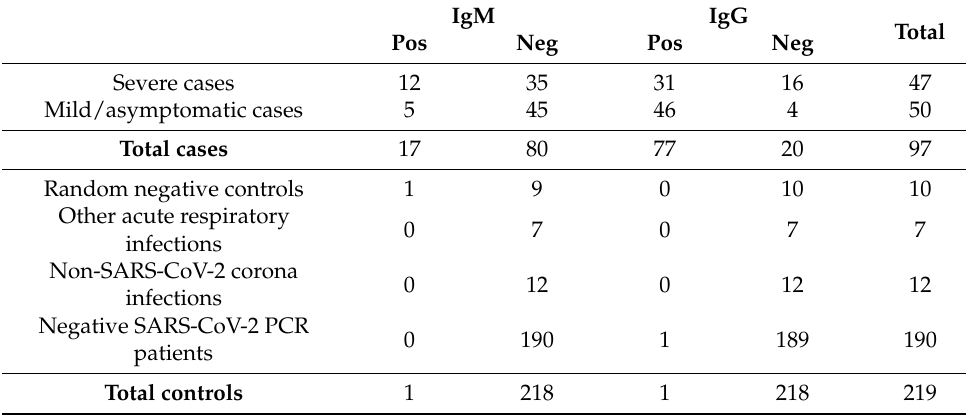
Table 1. Results of the Biozek COVID-19